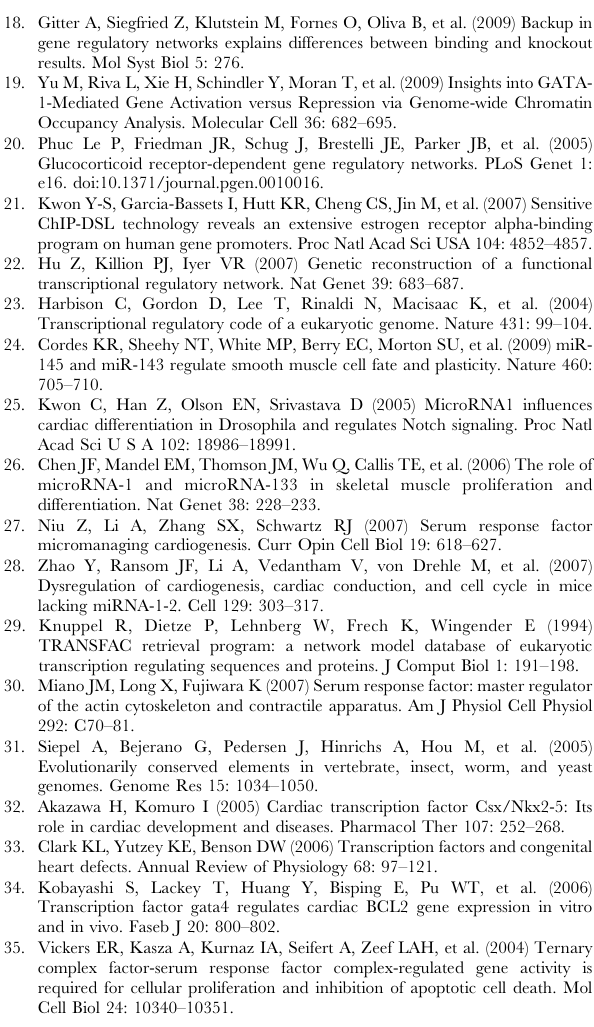
Table S18 List of miRNAs and target genes of differentially expressed miRNAs in HL-1 cells treated with Srf siRNAs. MiRNA loci based on mouse genome NCBIv37 (mm9). Matched reads to mature and star miRNA sequence based on miRBase annotations (release 14.0). For all miRNAs (in total 77) identified as significantly differentially expressed in at least one